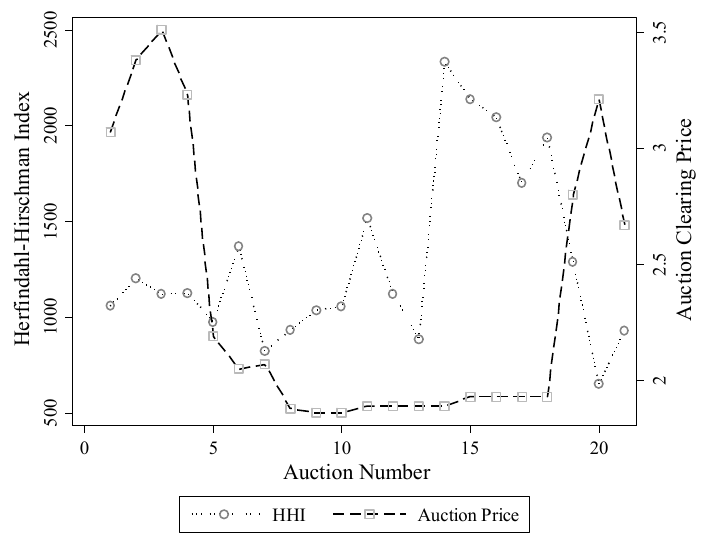
Figure 3. Market concentration and auction price in New England carbon auctions.